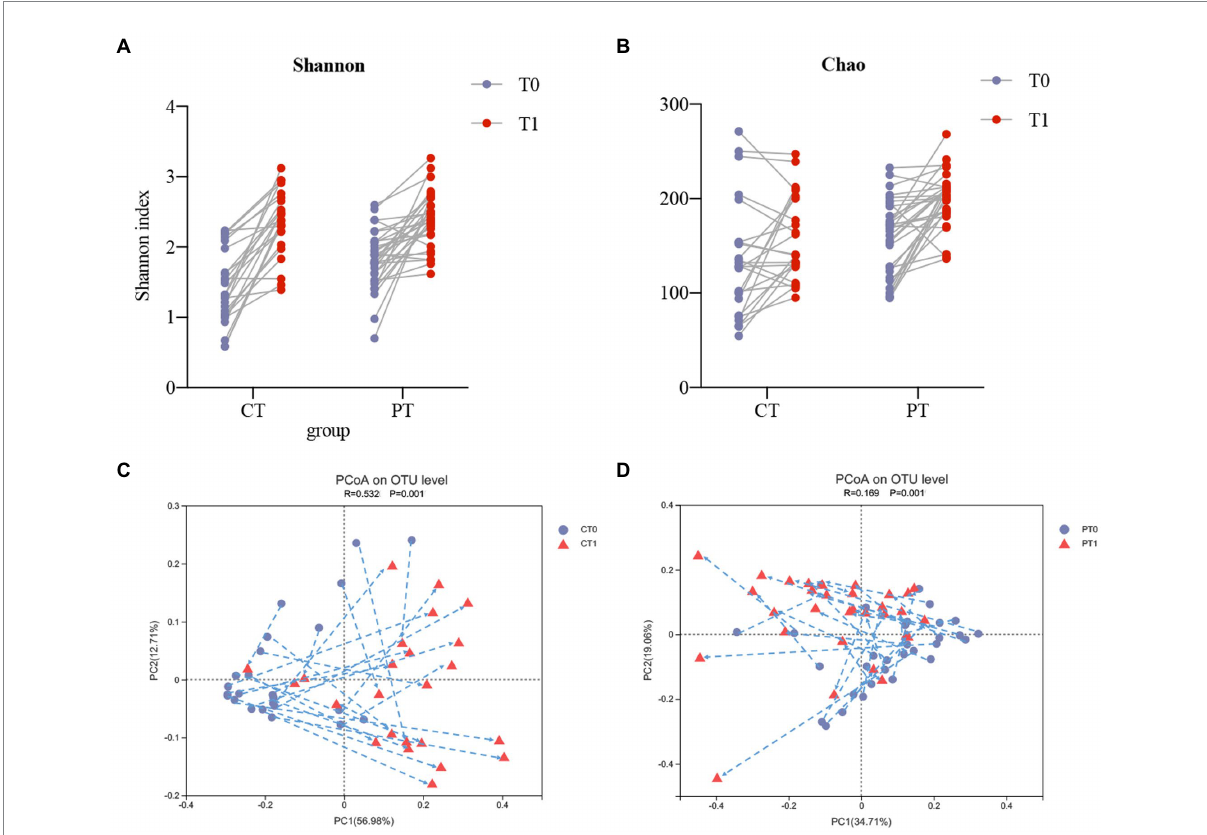
FIGURE 2 The longitudinal view of microbiota dynamics along with two lower primary central incisors teeth eruption. (A,B) Intraindividual shifts of bacterial richness and diversity shown by Shannon and Chao indices. (C,D) Intraindividual shifts of the microbiome community structure presented by PCoA, in accordance with the weighted normalized UniFrac distance, from baseline to the teeth eruption